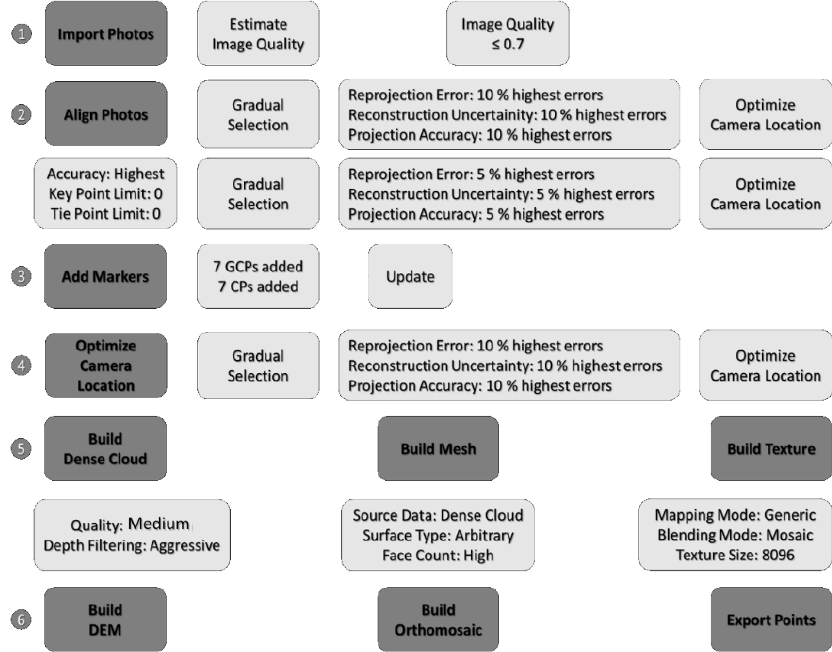
Figure 12. The image workflow process.